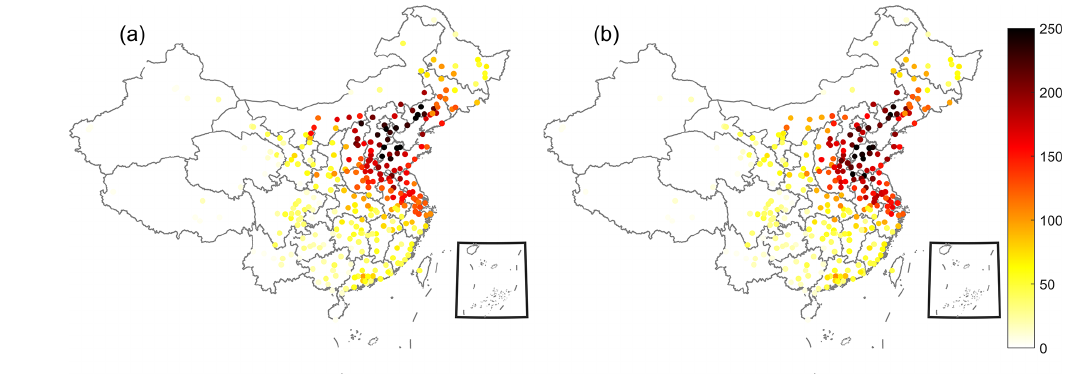
Figure 5. Distribution of in-weighted degree (a) and out-weighted degree (b) in the network of each node for positive cases.